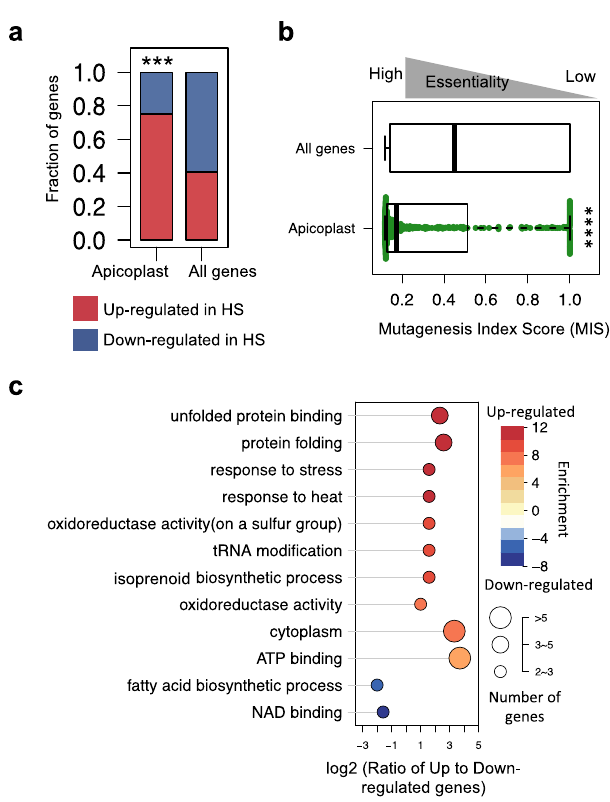
Fig. 4 Apicoplast-targeted genes are upregulated in response to heat shock. a Apicoplast-targeted genes tend to be increased in response to HS ( n = 39 upregulated vs. 12 downregulated genes) as compared to all non- apicoplast-targeted genes detected above threshold in RNAseq ( n = 415 upregulated vs. 611 downregulated genes). Apicoplast-targeted genes are as de fi ned in ref. 56 (***two-tailed FDR-corrected Fisher test p -value < 1e − 5). b Apicoplast-targeted genes tend to be highly essential during blood- stage vs. all other non-apicoplast-targeted genes detected above threshold in RNAseq. Median Mutagenesis Index Score (MIS) for apicoplast-targeted genes is much lower than median MIS for all other genes, indicating a lower tolerance for disruption and thus higher likely essentiality during blood- stage development than non-apicoplast-targeted genes (****two-tailed Wilcoxon test p -value < 1e − 15). Boxplots are drawn to present an interquartile range of values (IQR). Lower bound of each box = 1st quartile, middle line = median, upper bound = 3rd quartile, and whiskers extend to at most 1.5× IQR. c Apicoplast pathways regulated in response to HS. GO categories enriched in upregulated and downregulated apicoplast genes are shown on a scale from red to blue, respectively. The horizontal direction indicates the log-ratio between upregulated and downregulated apicoplast genes in each category. Circle size represents the number of genes per category. Source data are provided as a Source Data fi